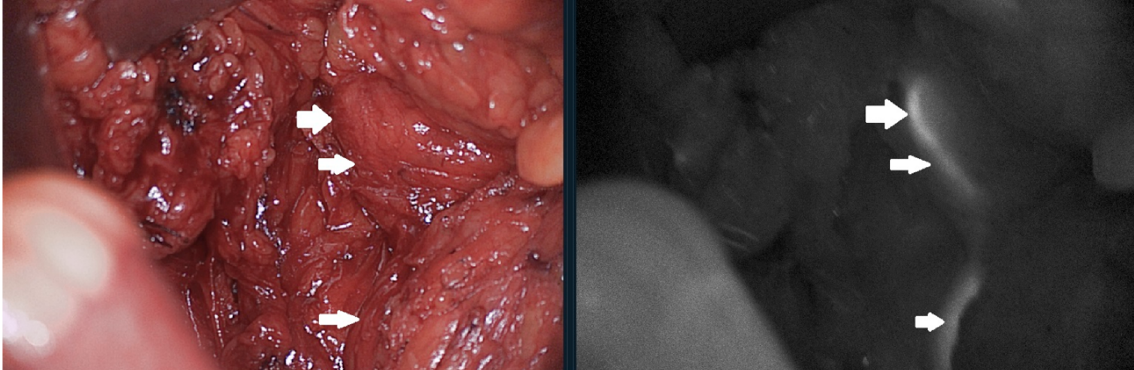
Figure 1. Ureter visualisation after methylene blue injection. Normal vision compared to fluorescent view. Arrows pointing the ureter in normal light and fluorescence.